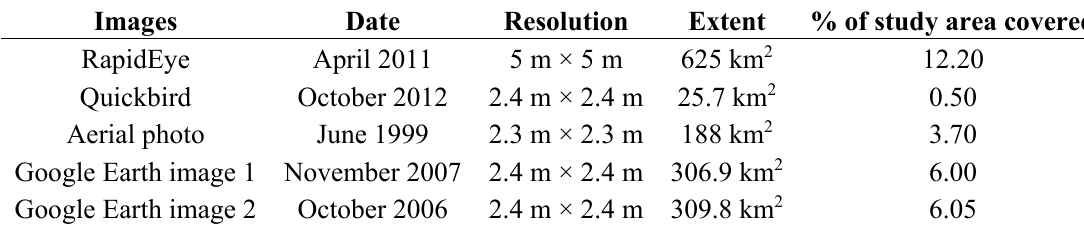
Table 3. High-resolution images used in the analysis.